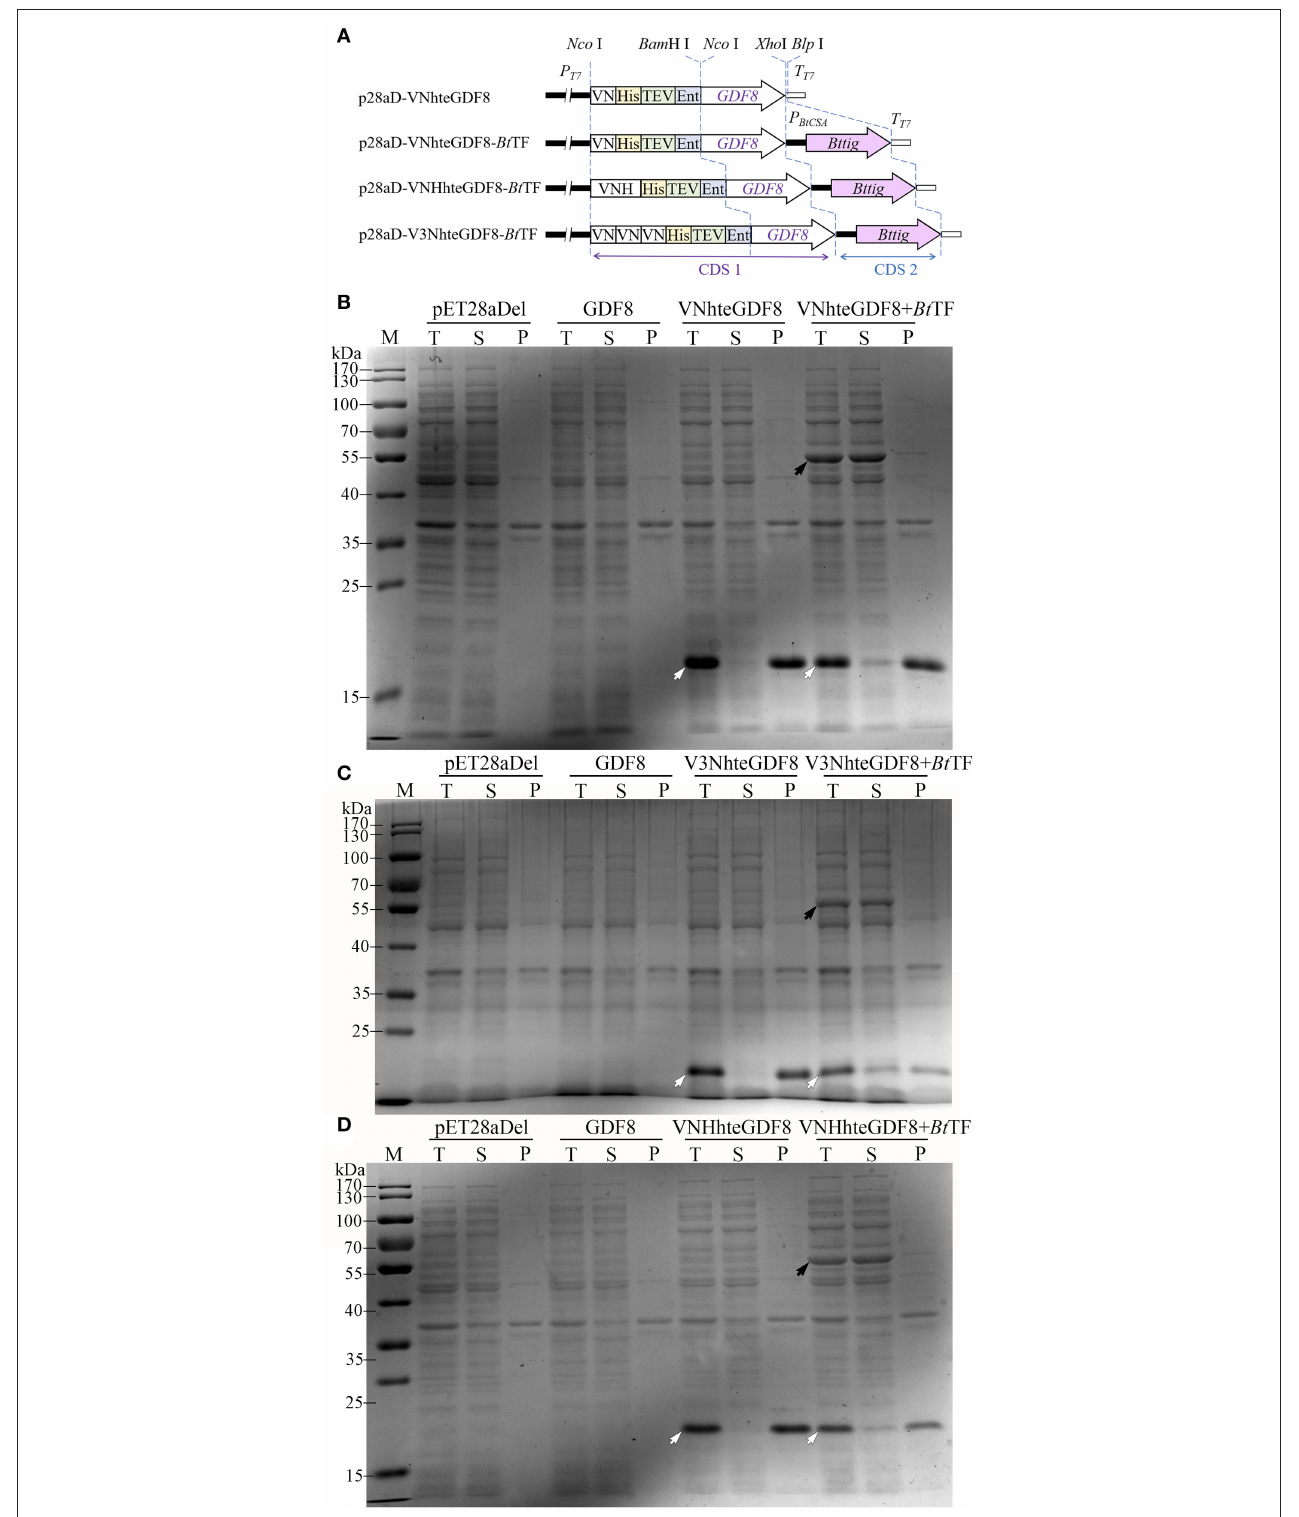
FIGURE 8 | The effect of the Vasp derivates and Bt TF on the expression of GDF8 protein. (A) The diagram of expression cassettes of VNhteGDF8, VNHhteGDF8, and V3NhteGDF8. The expression of VNhteGDF8 ( B , 16.9 kDa), V3NhteGDF8 ( C , 19.2 kDa), and VNHhteGDF8 ( D , 18.0 kDa) was analyzed by SDS-PAGE. For each sample, the total proteins (T), the soluble component after cell lysis (S), and the precipitates (P) were loaded. Lane “M” is the molecular weight standard. The black arrow indicates the Bt TF and the hollowed arrow indicates the recombinant proteins.